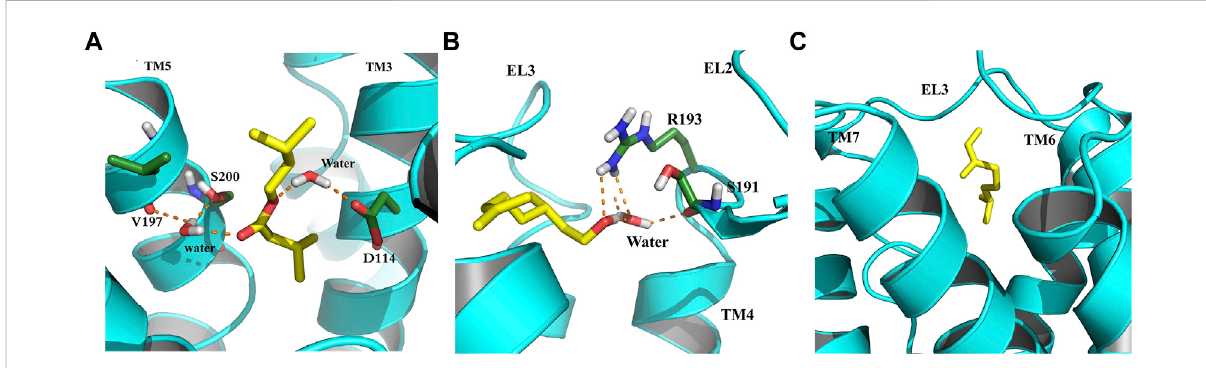
FIGURE 7 BindingmodesofselectedEOligandsinclude (A) B12, (B) B23,and (C) G04boundtotheTyrRafter150nsofCMD.Theproteinisrepresentedin cyan, the ligand is yellow, and the hydrogen bonds are represented as orange dashed lines.